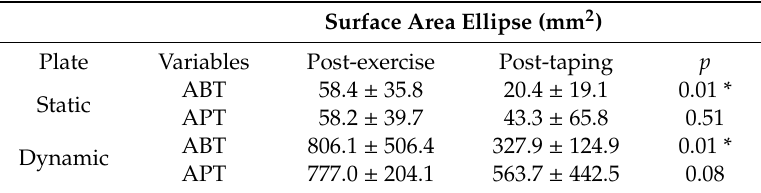
Table 6. Comparison of variations in surface area ellipses on a static and a dynamic plate with eyes closed after fatigue-inducing exercise and after